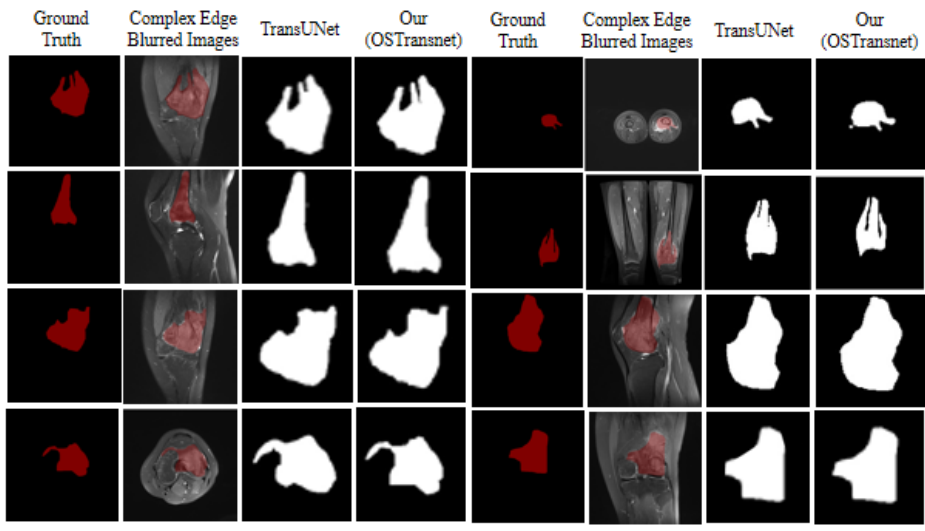
Figure 10. Segmentation effect with blurred edges.